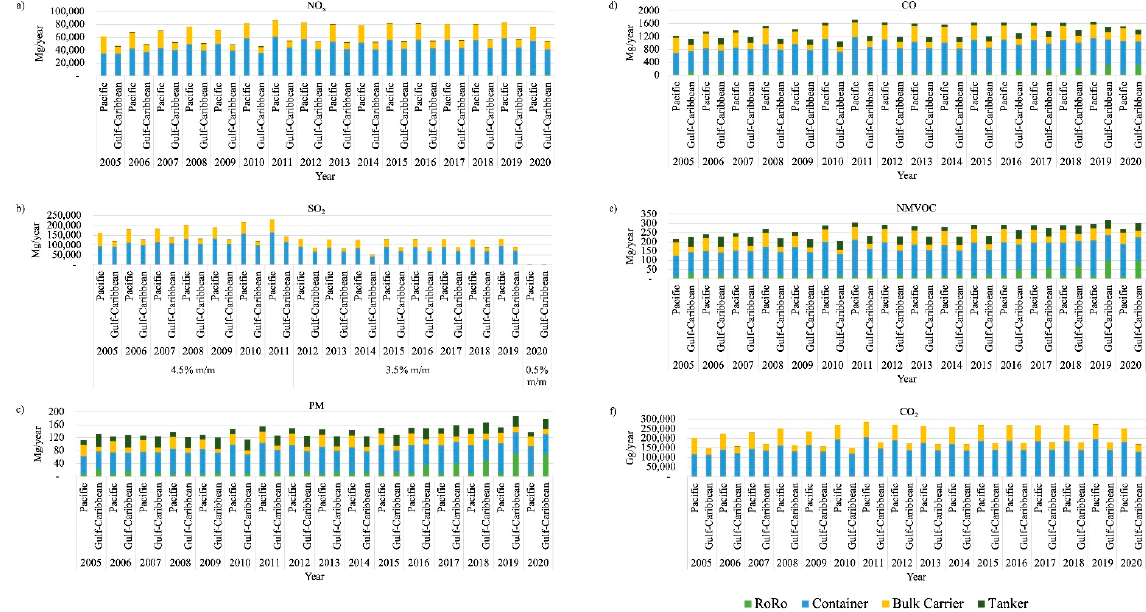
Figure 5. Atmospheric emissions from 2005 to 2020 for ( a ) NO x , ( b ) SO 2 , ( c ) PM, ( d ) CO, ( e ) NMVOC and ( f ) CO 2 . We utilized the 2020 database to analyze the atmospheric emission level of each port Atmospheric SO 2 emissions are reduced when fuel sulfur content decreases. located in the Pacific and Gulf-Caribbean, as it represents the most current information in Mexico. The number of ships served at each Mexican port are shown in Figure 6. Isla de Cedros, Guerrero Negro, and Punta Venado are characterized by the handling of Bulk Carrier goods, whereas Rosarito, La Paz, Coatzacoalcos, Cayo Arcas, and Progreso are specific to the movement of Fluids or Liquids. Manzanillo, Lázaro Cárdenas, Altamira, and Veracruz. Manzanillo and Lázaro Cárdenas are the principal ports for the movement of Container vessels on the Pacific, and Altamira and Veracruz are the corresponding ports on the Gulf-Caribbean. It should be noted that the number of Container vessel that have been registered in Manzanillo (1256) represents approximately twice those regis- tered at Altamira (535) and Veracruz (642). The movement of general and loose cargo by